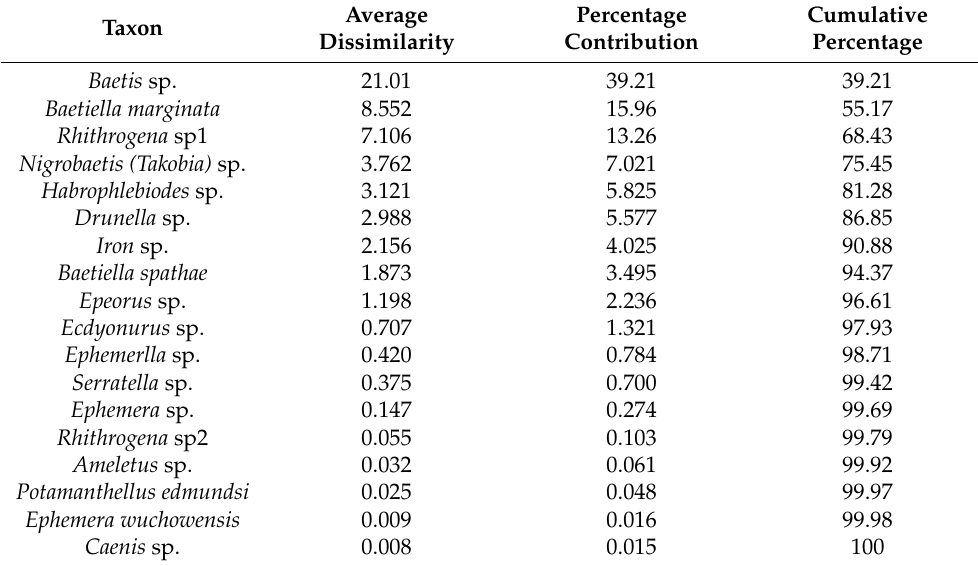
Table 3. The analysis of similarity percentage (SIMPER) for mayfly taxa in the three analyzed streams. The SIMPER analysis determines the percentage contribution of each species to the Bray–Curtis dissimilarity